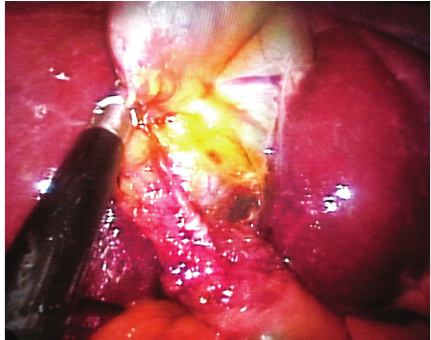
Figure 4: Single cystic duct, in front of dissected cystic artery, following the dissection of Calot.